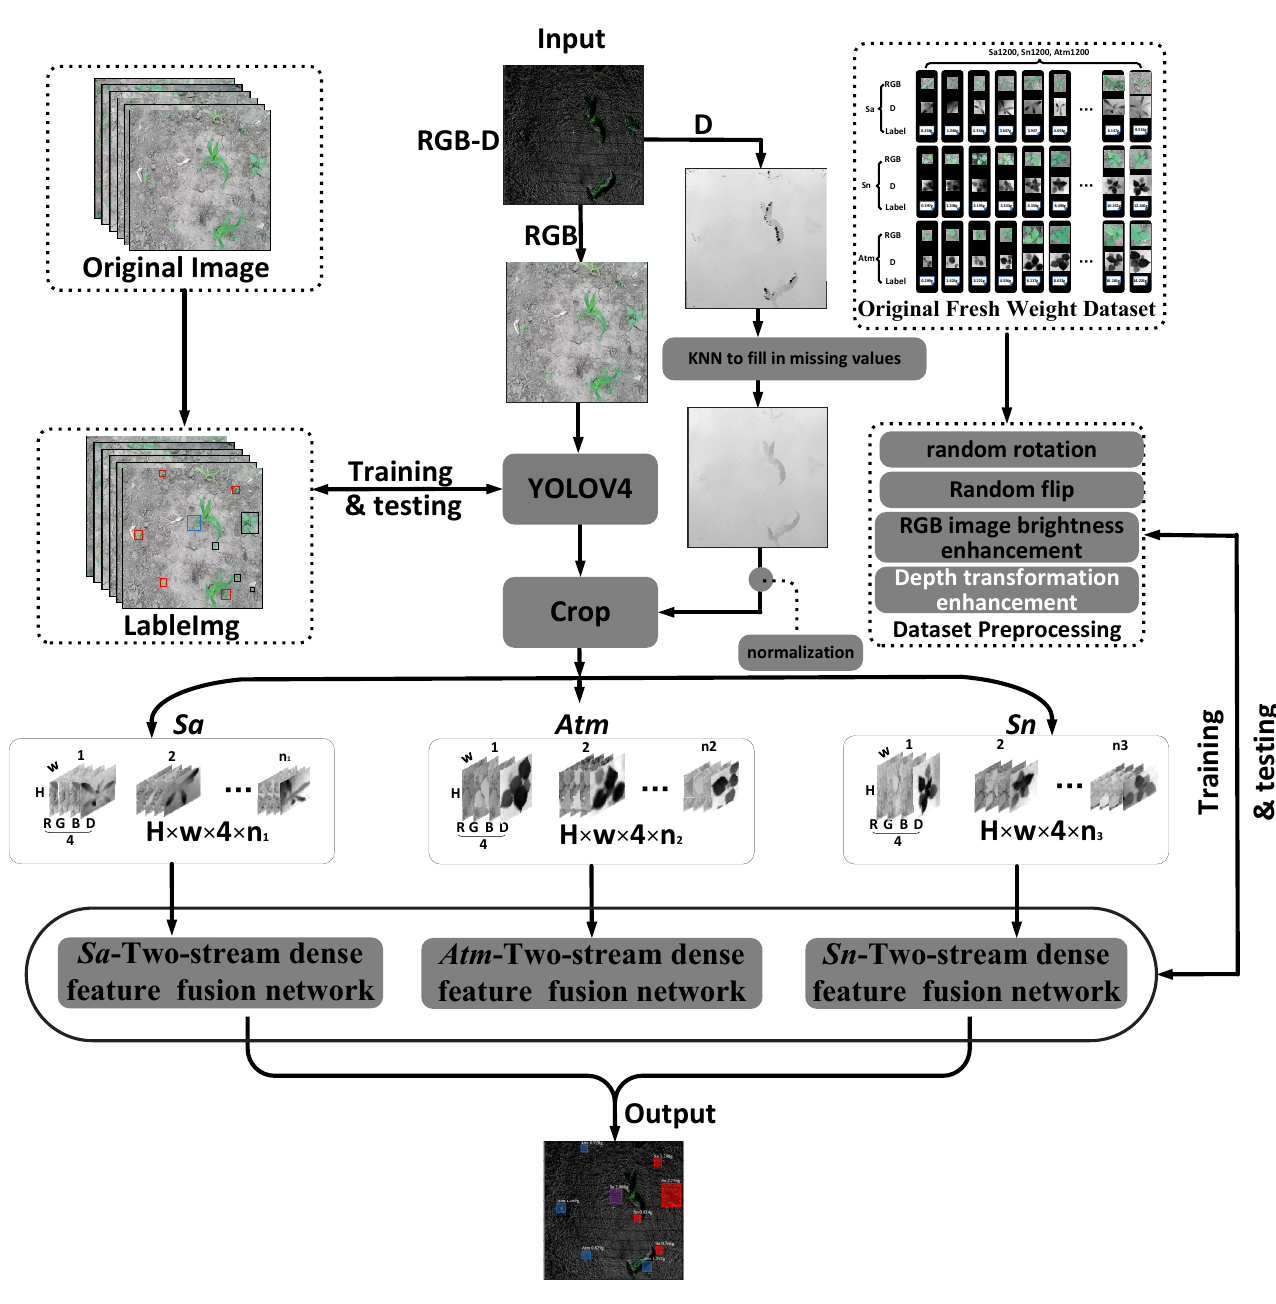
Figure 2. Technical route. The content in the dashed box in the figure represents the training and testing process of the model described in this article. The other modules represent the flow chart to realize the functions of this research. Among them, Abutilon theophrasti Medicus is abbreviated as Atm , Sonchus arvensis is abbreviated as Sa , and Solanum nigrum is abbreviated as Sn .